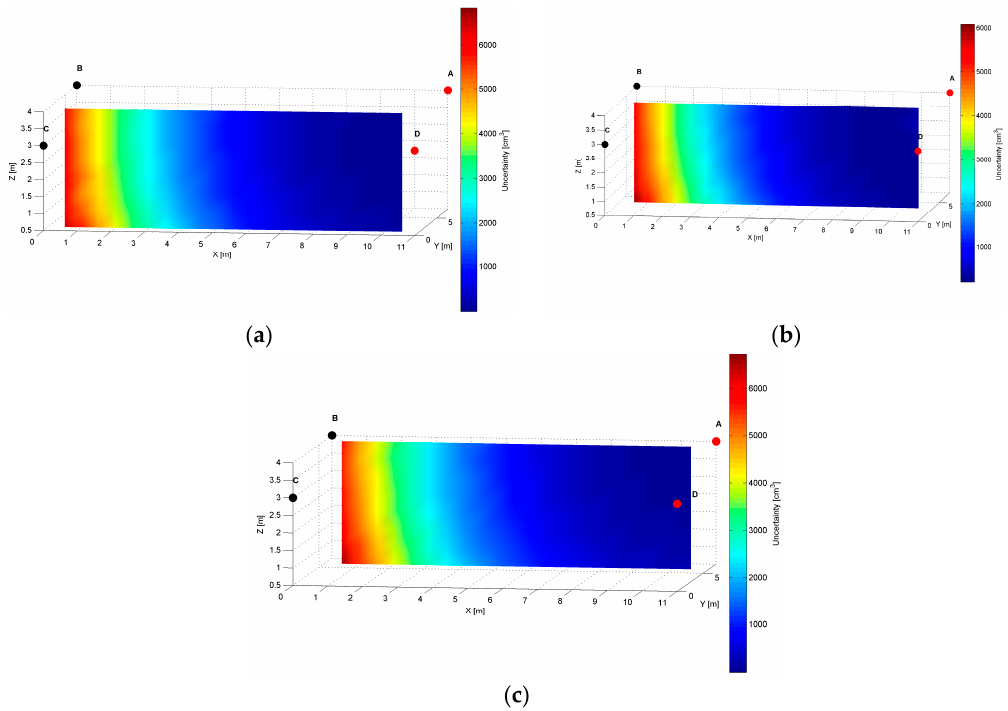
Figure 9. Cross-section ( XZ plane) plots of uncertainty-precision distribution for location sensors A and D at ( a ) y = 1.00 m; ( b ) y = 3.50 m; ( c ) y = 6.00 m. All plots are in different colour scales.